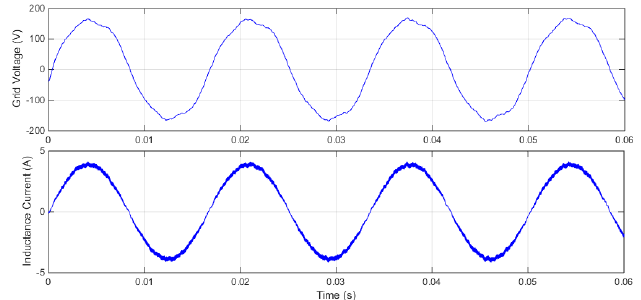
Fig. 12. Output voltage and output current when L g = 19.5 mH ( τ i =